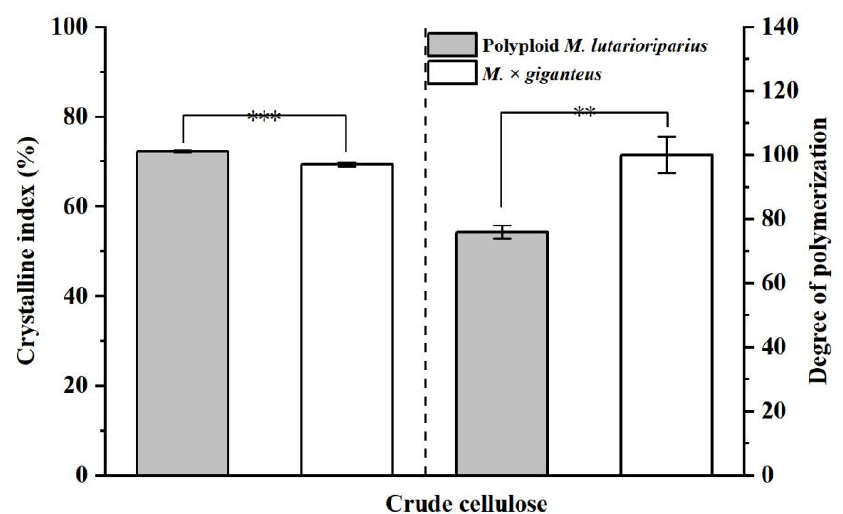
Figure 5. Crystalline index and degree of polymerization of crude cellulose in polyploid Miscanthus lutarioriparius and Miscanthus × giganteus . ** Significant difference at p ≤ 0.01, *** Significant difference at p ≤ 0.001. Vertical bar are standard deviation ( n = 3).